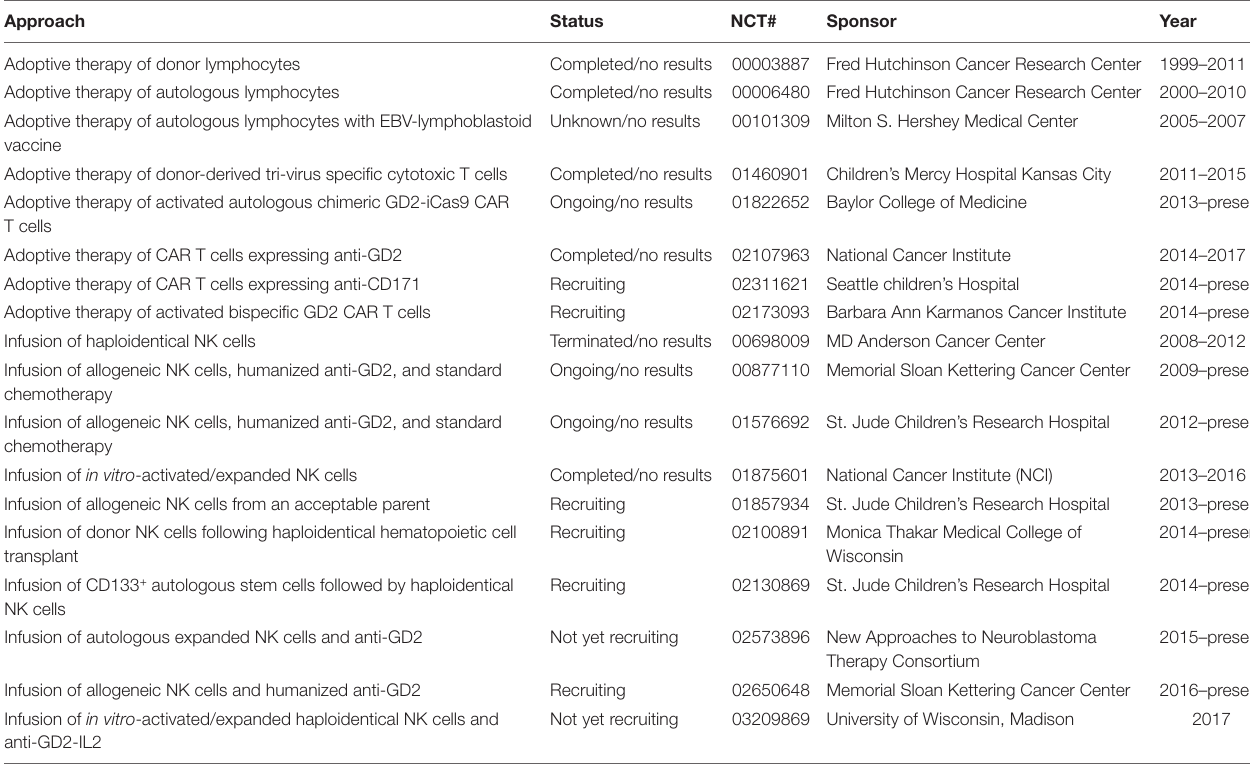
tAble 1 | Present and past adoptive immunotherapy trials for refractory/recurrent/relapsed neuroblastoma.